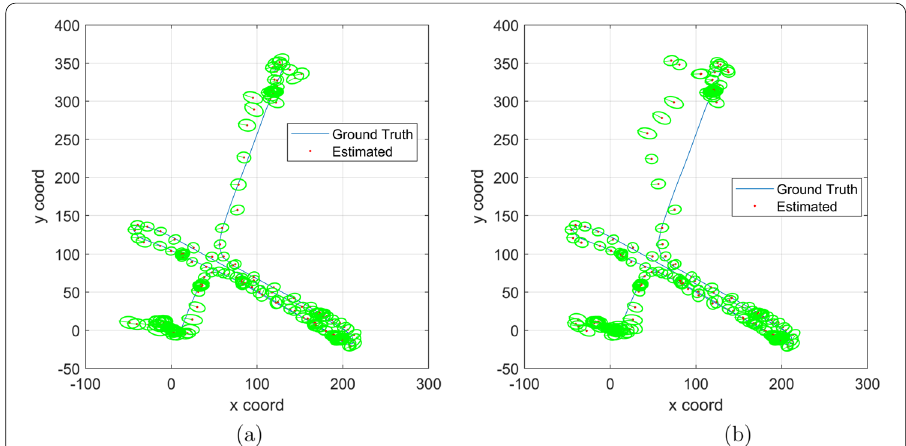
Fig. 11 Estimated poses and 95% confidence ellipses for the GPS data using a proposed variance estimators and b maximum likelihood variance